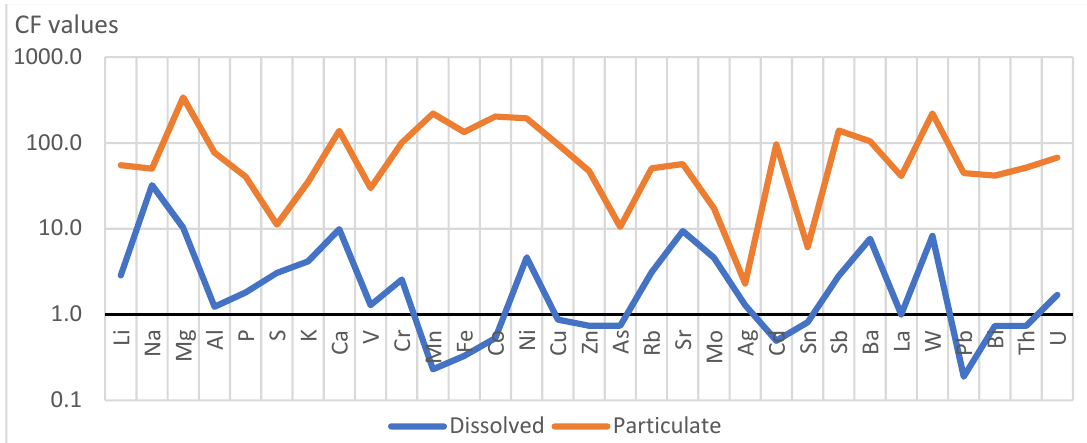
Figure 4. Logarithmic contamination factor values computed by using geometric means. The EF values for trace and major elements are shown in Figure 5. The background area was characterized by the most significant enrichment in Cd, Ag, Sb, Zn and Cu (EF > 1000) and the minimal enrichment in Fe and V (Figure 5a).